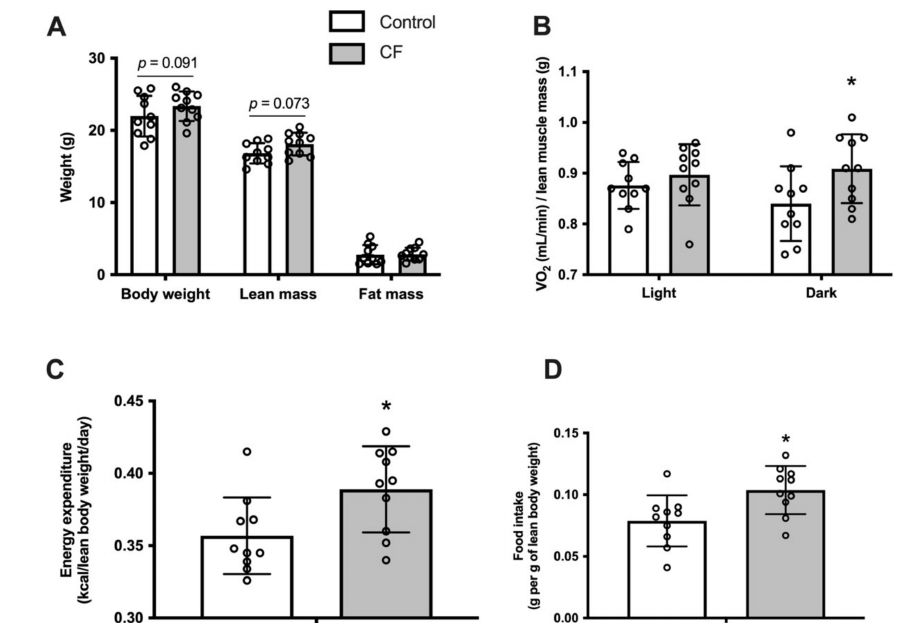
Figure 1. Fifteen days of CF supplementation influences body composition and increases energy expenditure in 129S1/SvlmJ mice. ( A ) Body weight, lean mass, and fat mass. ( B ) Measurement of whole-body oxygen consumption during light and dark phases. ( C ) Daily energy expenditure. ( D ) Daily food intake. n = 10, means ± SD. * p < 0.05 vs. the control